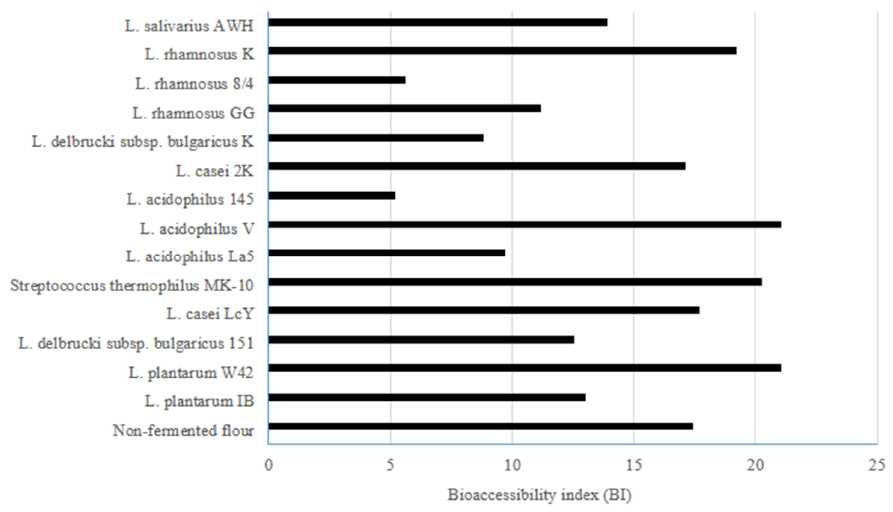
Figure 1. The bioaccessibility index (BI) indicating the potential bioaccessible ACE inhibitory activity of water biscuits formulated from buckwheat flour fermented by lactic acid bacteria: BI value > 1 indicates high bioaccessibility; BI value < 1 indicates low bioaccessibility.